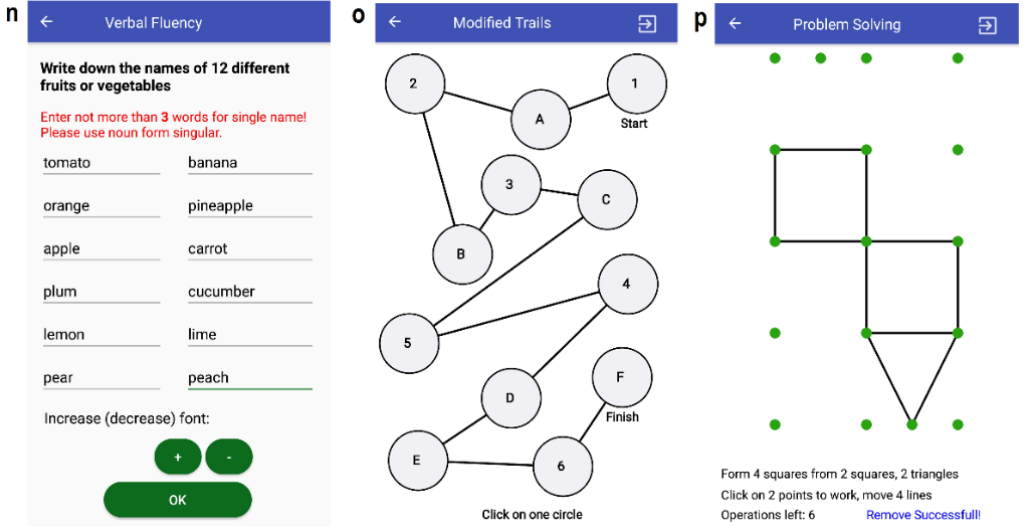
Figure 3. Screenshots of the mobile app tasks: T11: verbal fluency (n—entering 12 items); T12: modified trials (o—completing schema); T13: problem solving (p—after line remove operation).